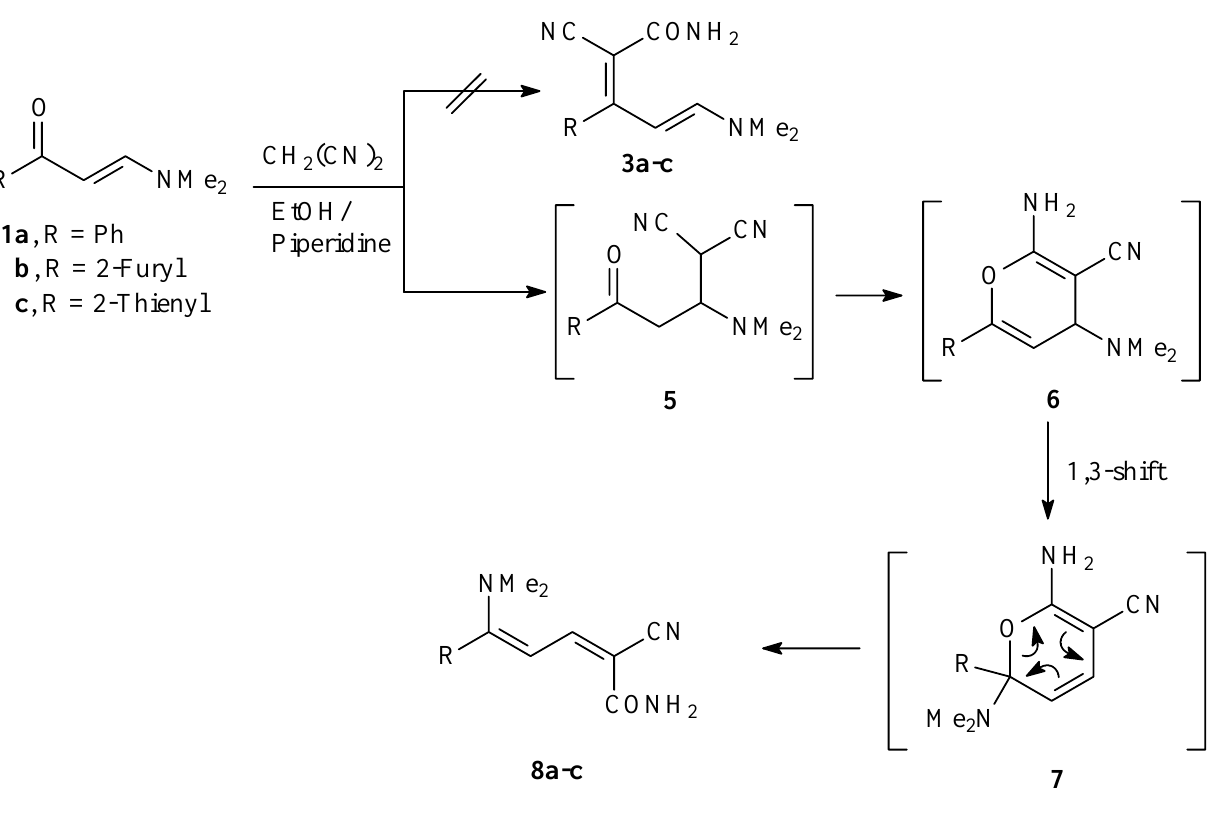
Scheme 3. Proposed mechanism for the nitrozation and coupling reactions of